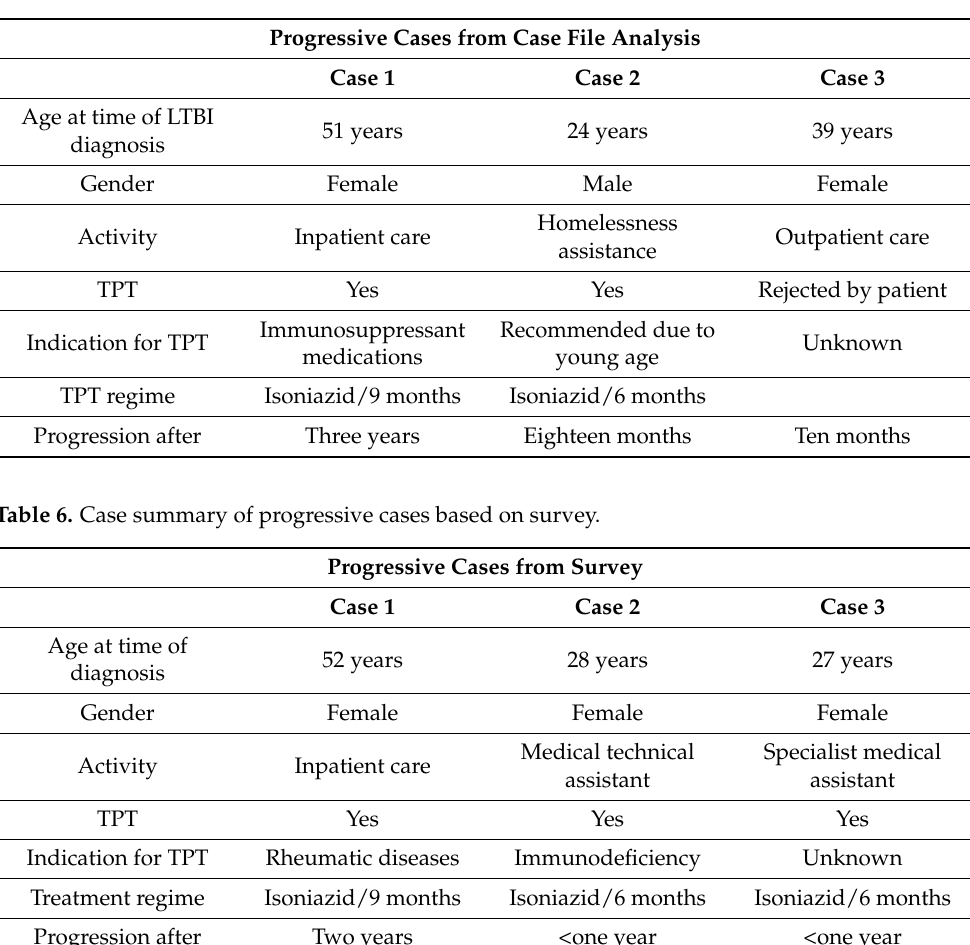
Table 5. Case summary of progressive cases based on file analysis.